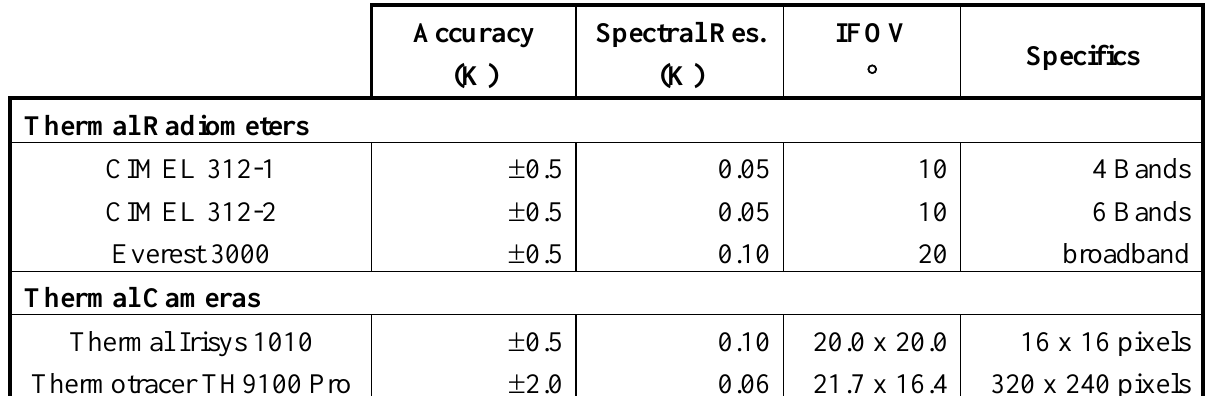
Table 1. Thermal instruments used on the goniometer.